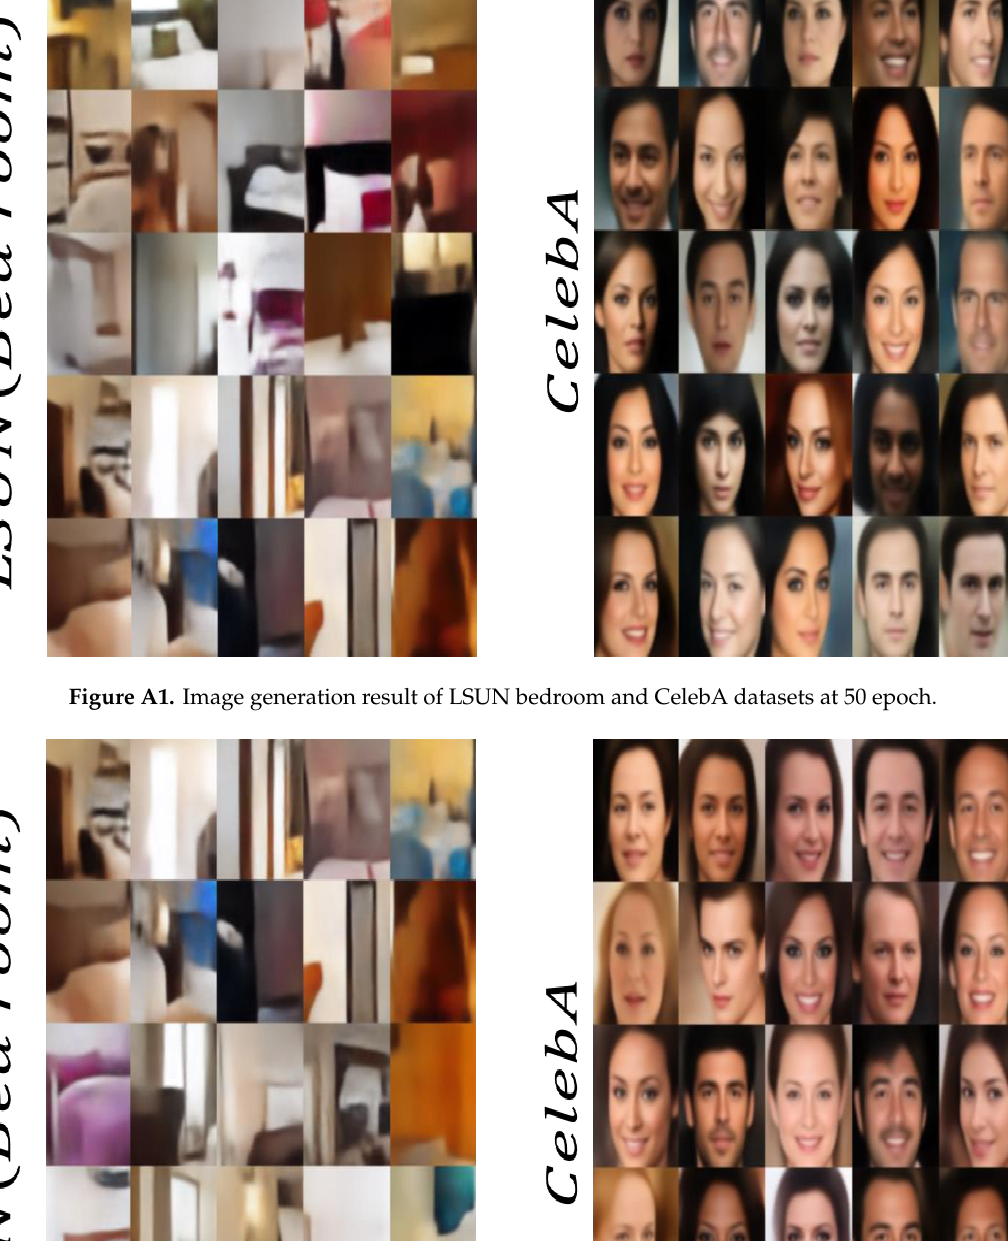
Figure A3. I mage generation result of LSUN bedroom and CelebA datasets at 200 epoch. Mode collapse did not occur in the LSUN bedroom image generated in the VAE up to 200 epoch. However, there was a 'blur' phenomenon that deteriorated the quality of the image. In Figures 20-22, we determined that the experimental environment of the CelebA dataset is not suitable for generating the LSUN bedroom data.